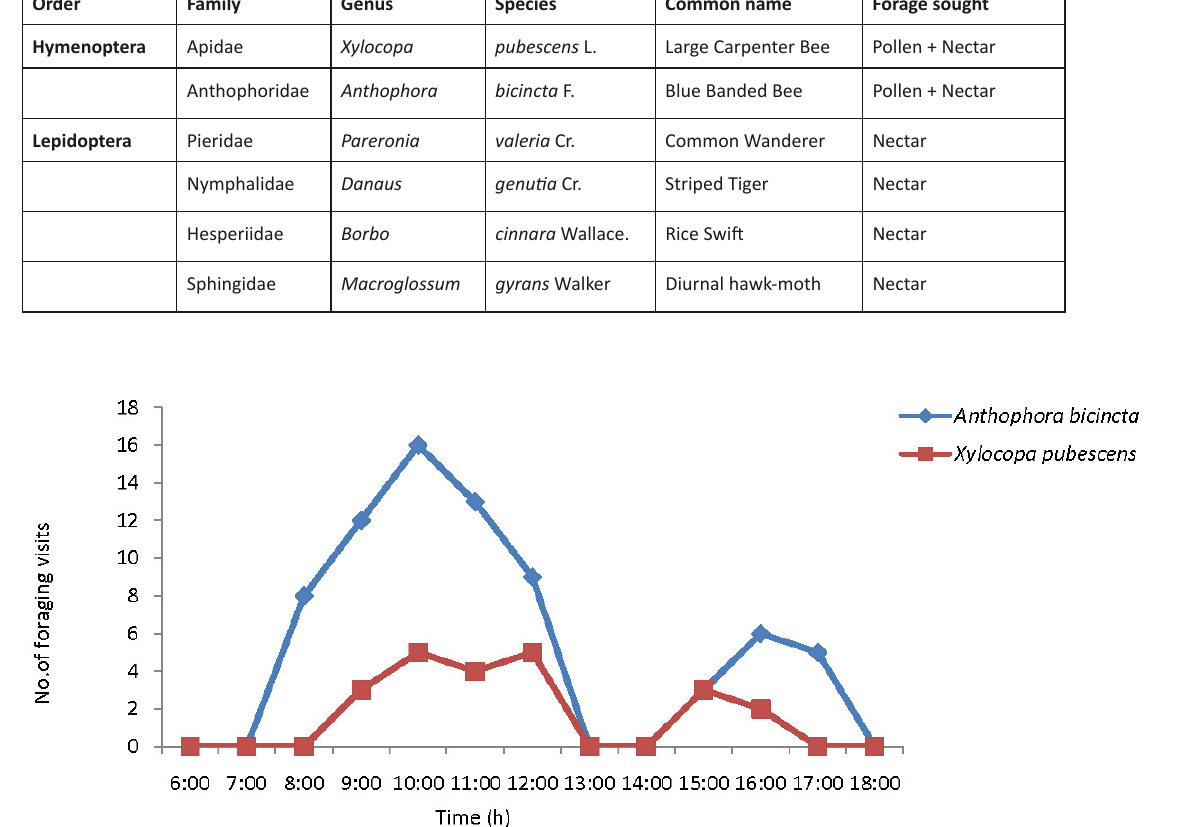
Figure 2. Hourly foraging activity of bees on Clerodendrum